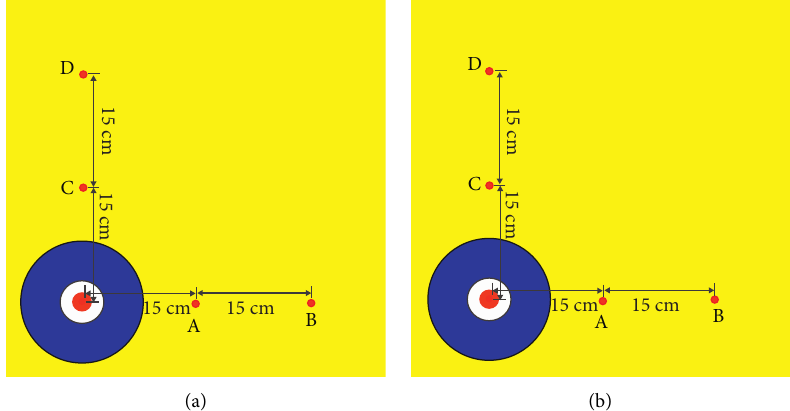
Figure 8: Key points on single-hole loading. (a) Single-hole loading. (b) Double-hole